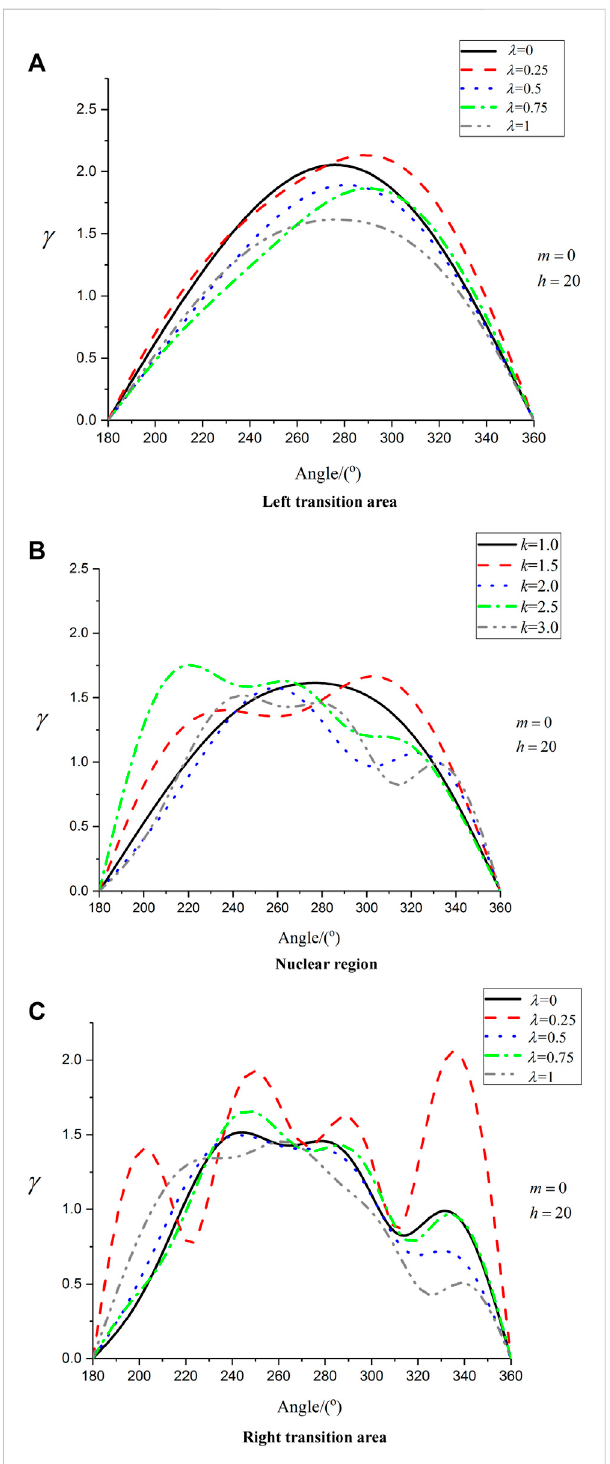
FIGURE 6 Distribution of hoop dynamic stress concentration factor of semi-circular depression when the thickness of the ribbon domain is h (cid:2) 20. (A – C) represent the results of these three subsets: Left transition area, Nuclear region and Right transition